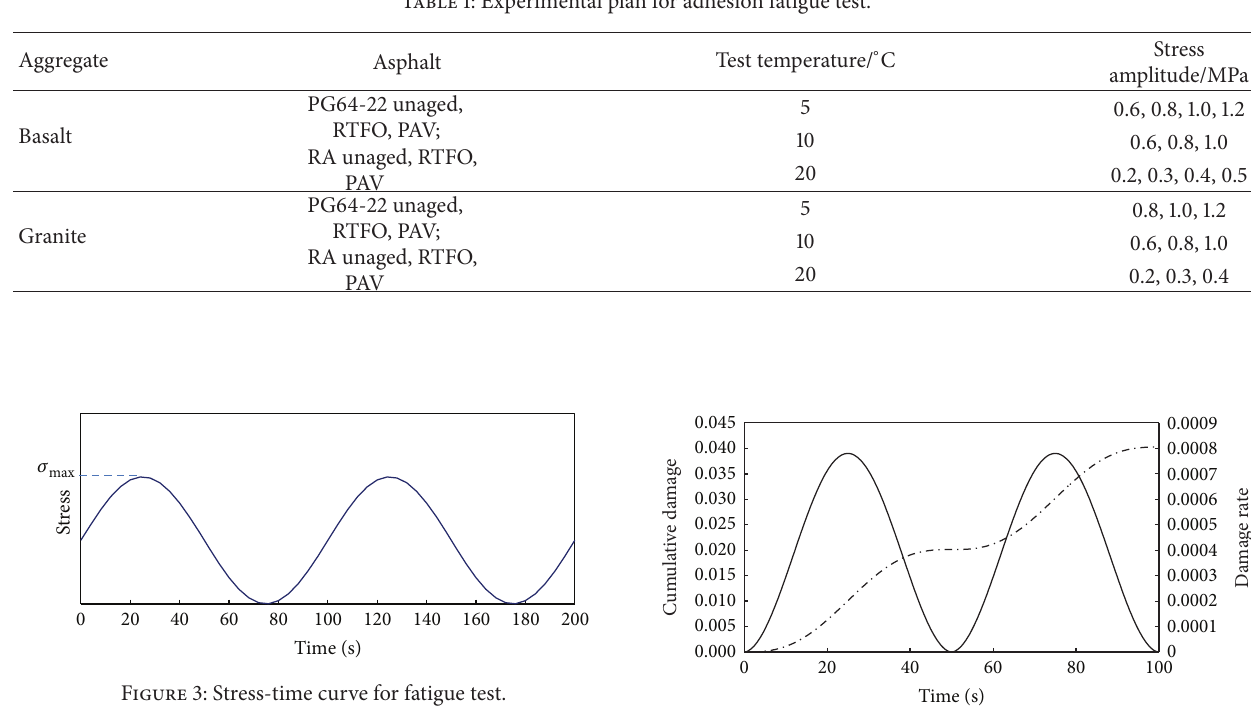
Table 1: Experimental plan for adhesion fatigue test.